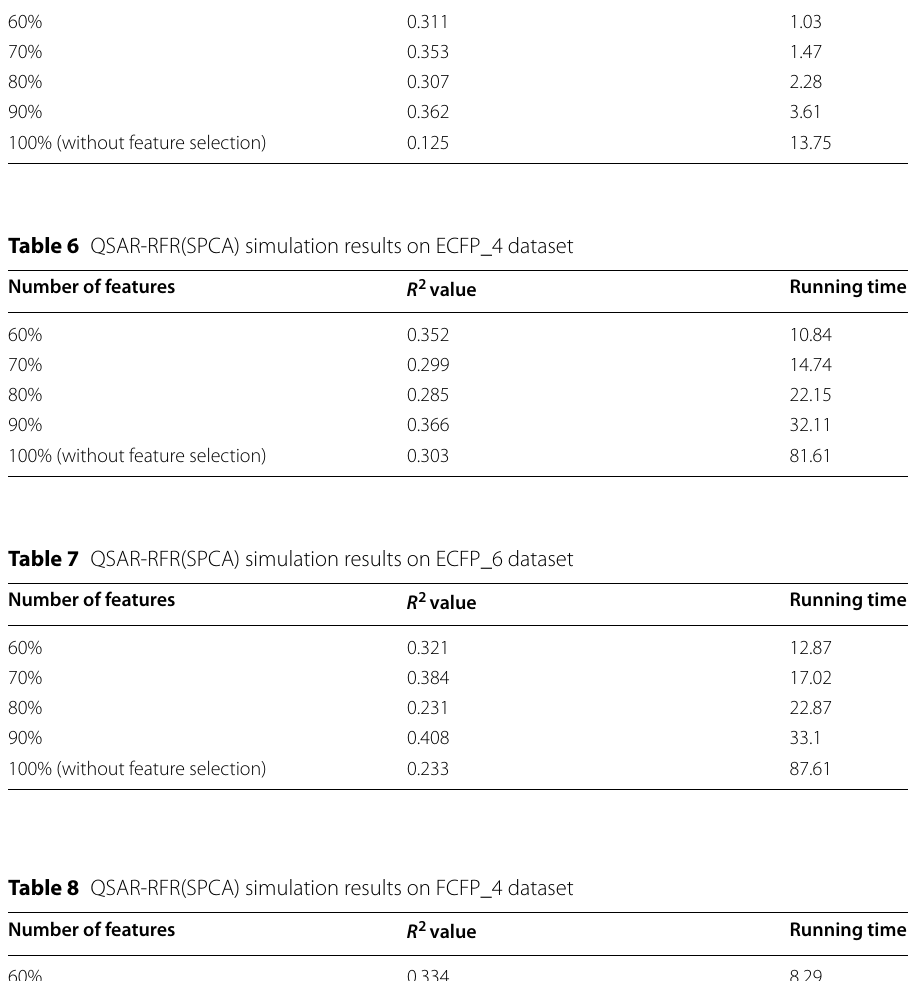
Table 5 QSAR-RFR(PCA) simulation results on FCFP_6 dataset Number of features